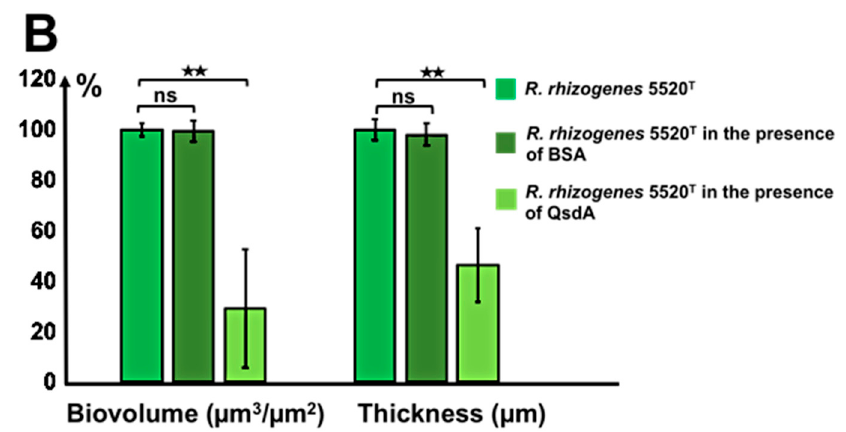
Figure 6. Effect of the purified AHL-lactonase QsdA on R. rhizogenes biofilm formation. Control conditions for biofilm formatin were established by substituting QsdA by bovine serum albumin (BSA). R. rhizogenes was transformed with the pHC60-gfp plasmid to tag bacteria by the constitutive expression of gfp (green fluorescent cells). Top view, 3D representation and side view of the R. rhizogenes biofilm in the presence of 100 µL of elution buffer alone ( A1 ) or containing the BSA ( A2 ) or the QsdA lactonase ( A3 ). COMSTAT analysis of the biovolume and thickness of the biofilms developed ( B ). The data shown are the means of three measurements from three independent experiments. Significant differences in biovolume and thickness values (Mann–Whitney test; p -value < 0.01) are indicated by asterisks ( ★★ p < 0.01); ns, not significant.